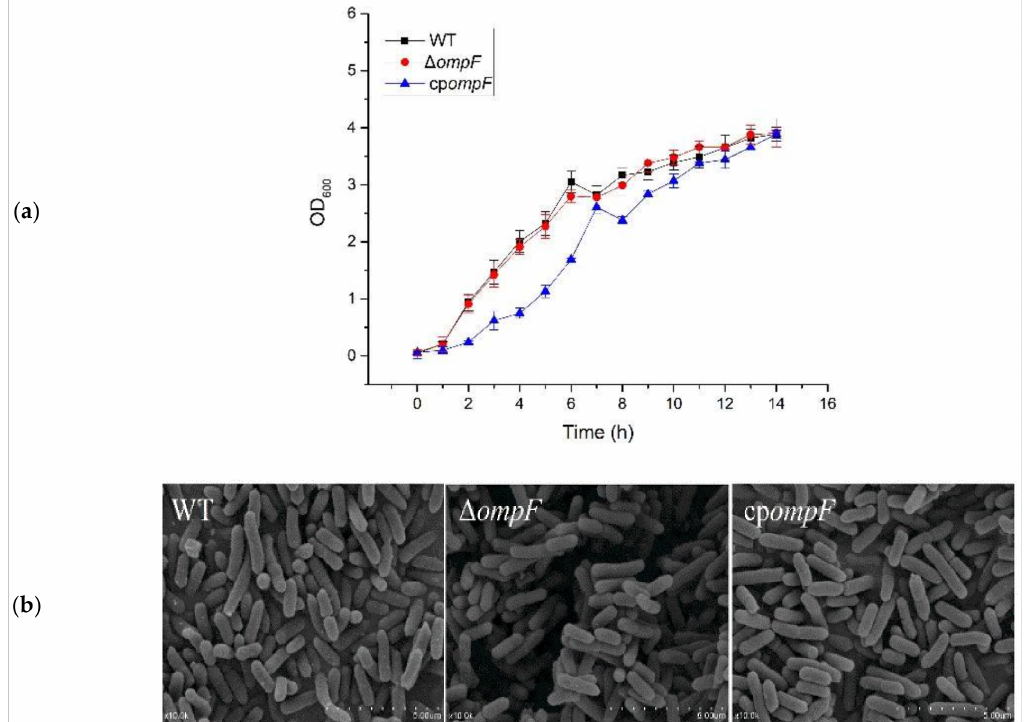
Figure 2. Growth and cell morphology of C. sakazakii in LB medium. ( a ) Growth of C. sakazakii in LB medium. Error bars represent the standard deviations from independent experiments performed in triplicate. ( b ) SEM to observe the cell morphology of WT, ∆ ompF and cp ompF. Panels: WT, C. sakazakii ATCC BAA-894; ∆ ompF , mutant strain; cp ompF , complementation strain.